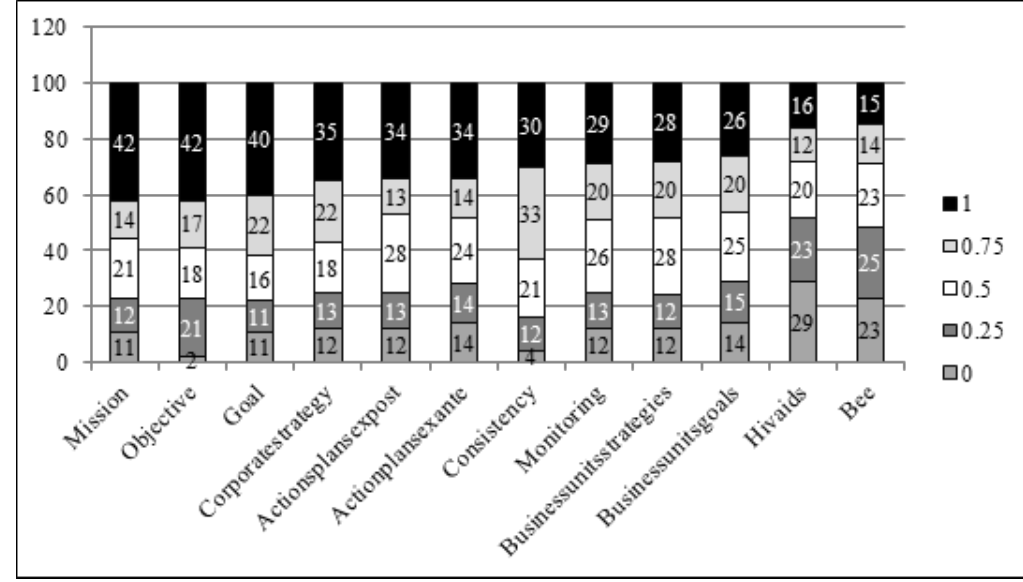
Figure 1: A graphical representation of scores for the sample companies